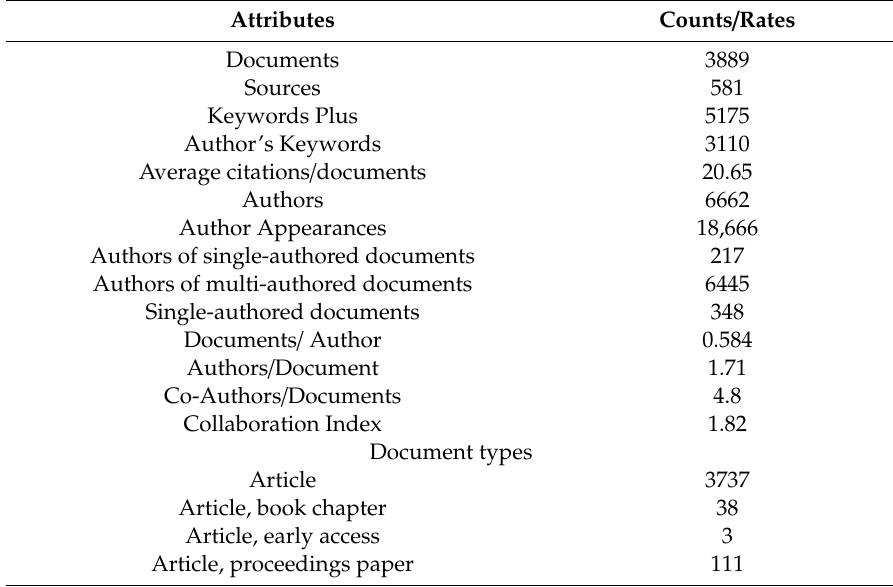
Table 1. Types and characteristics of MAP research from